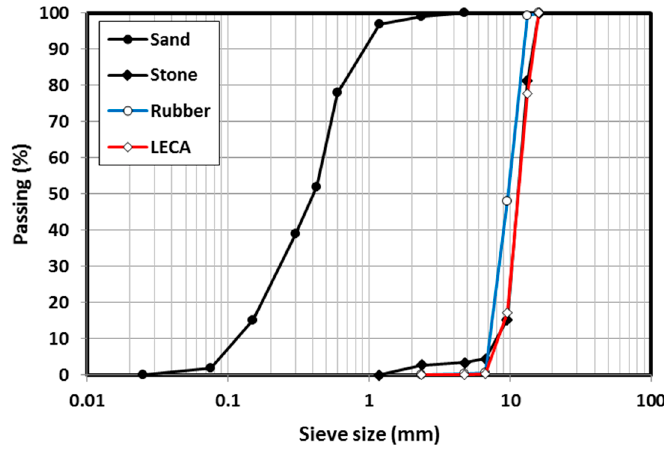
Figure 2. Sieve analysis of the aggregates used.